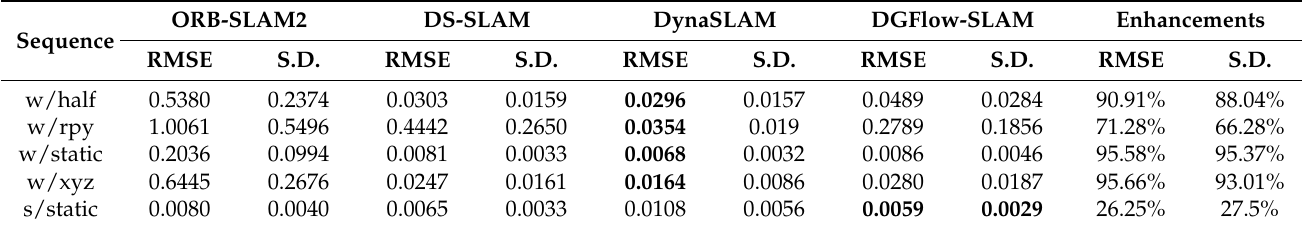
Table 1. Result of absolute trajectory error (ATE).